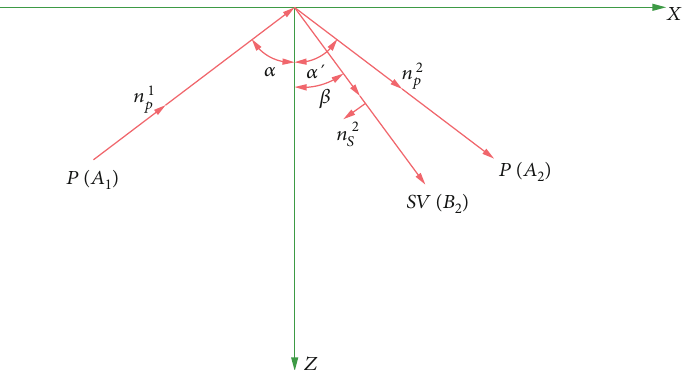
Figure 1: P wave